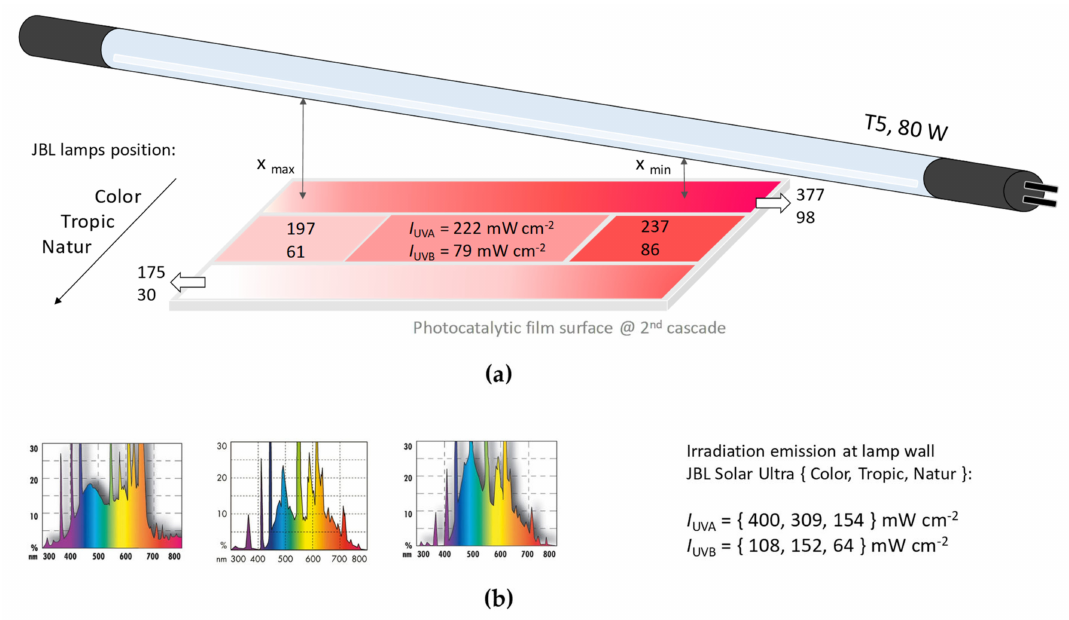
Figure 2. ( a ) Average incident irradiation intensities on photocatalyst surface in regard to lamps’ positioning (measurements at 2nd cascade of FPCR were given as an example); ( b ) lamps’ emission spectra as obtained by the manufacturer